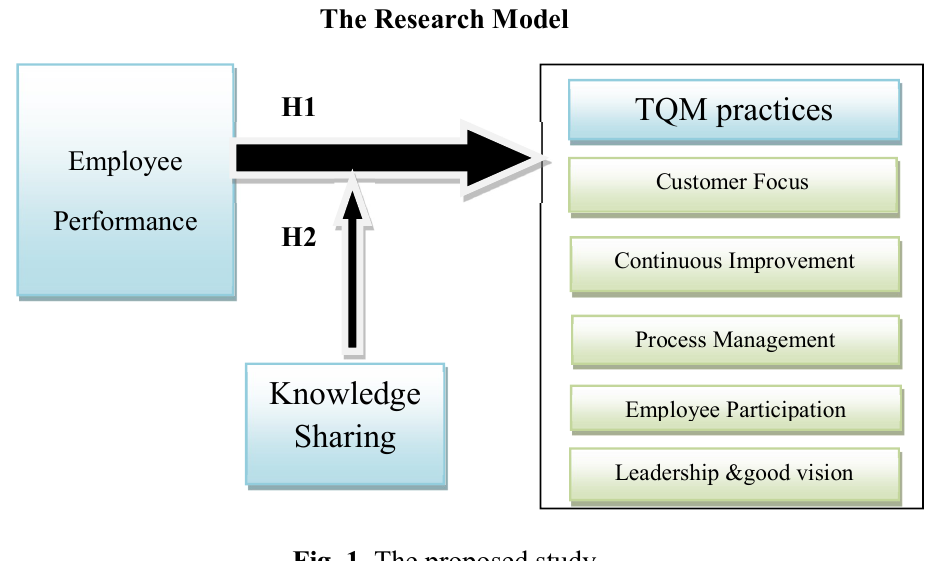
Fig. 1. The proposed